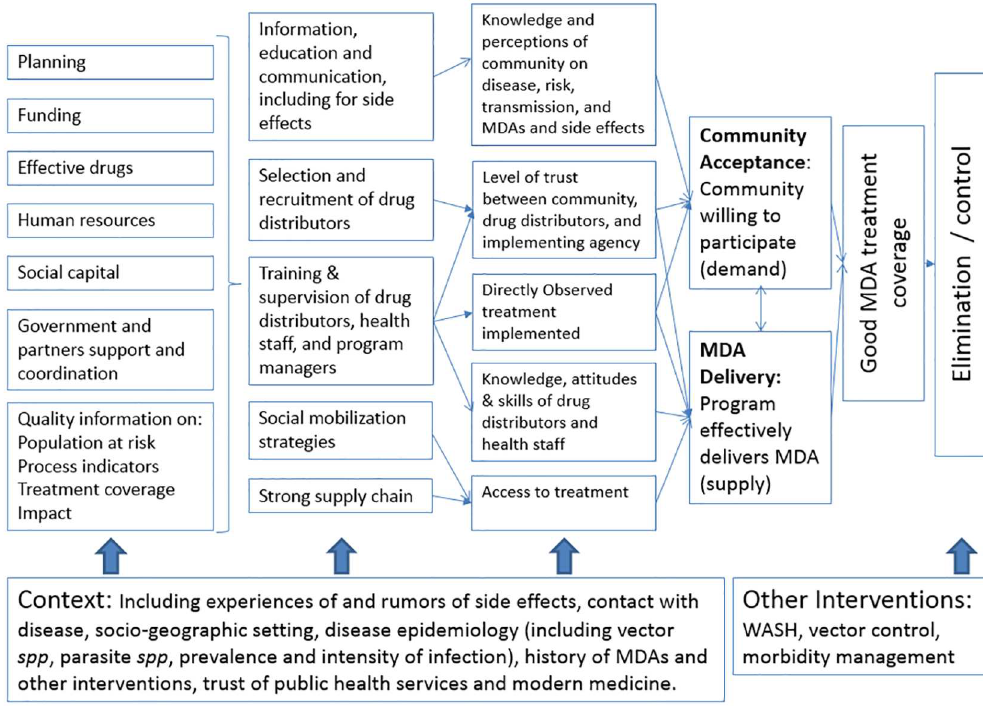
Fig 6. Theory of change for NTD